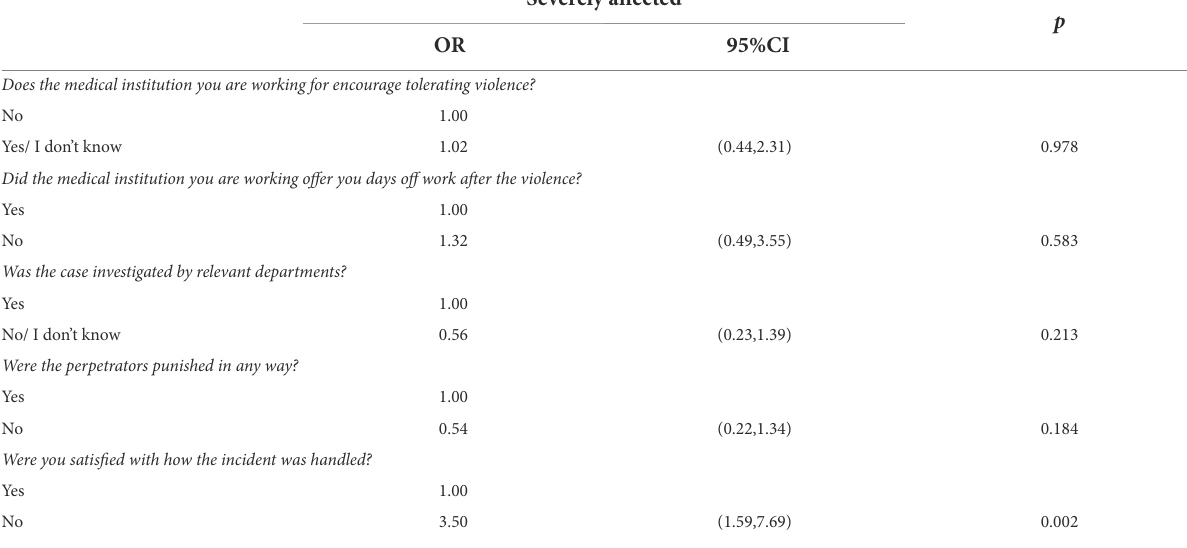
TABLE 4 Regression coefficients for the impact of physical WPV on health sector workers and potential remedial measures with adjustment for social demographic characteristics.